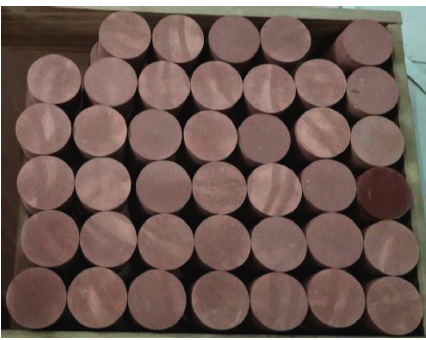
Figure 1: Red sandstone